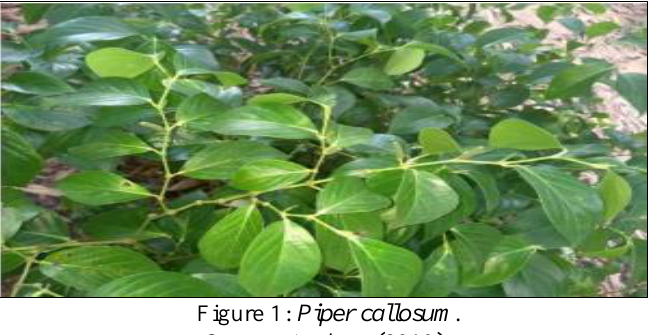
Figure 6. Organoleptic properties and Figure 7. Turbidity.